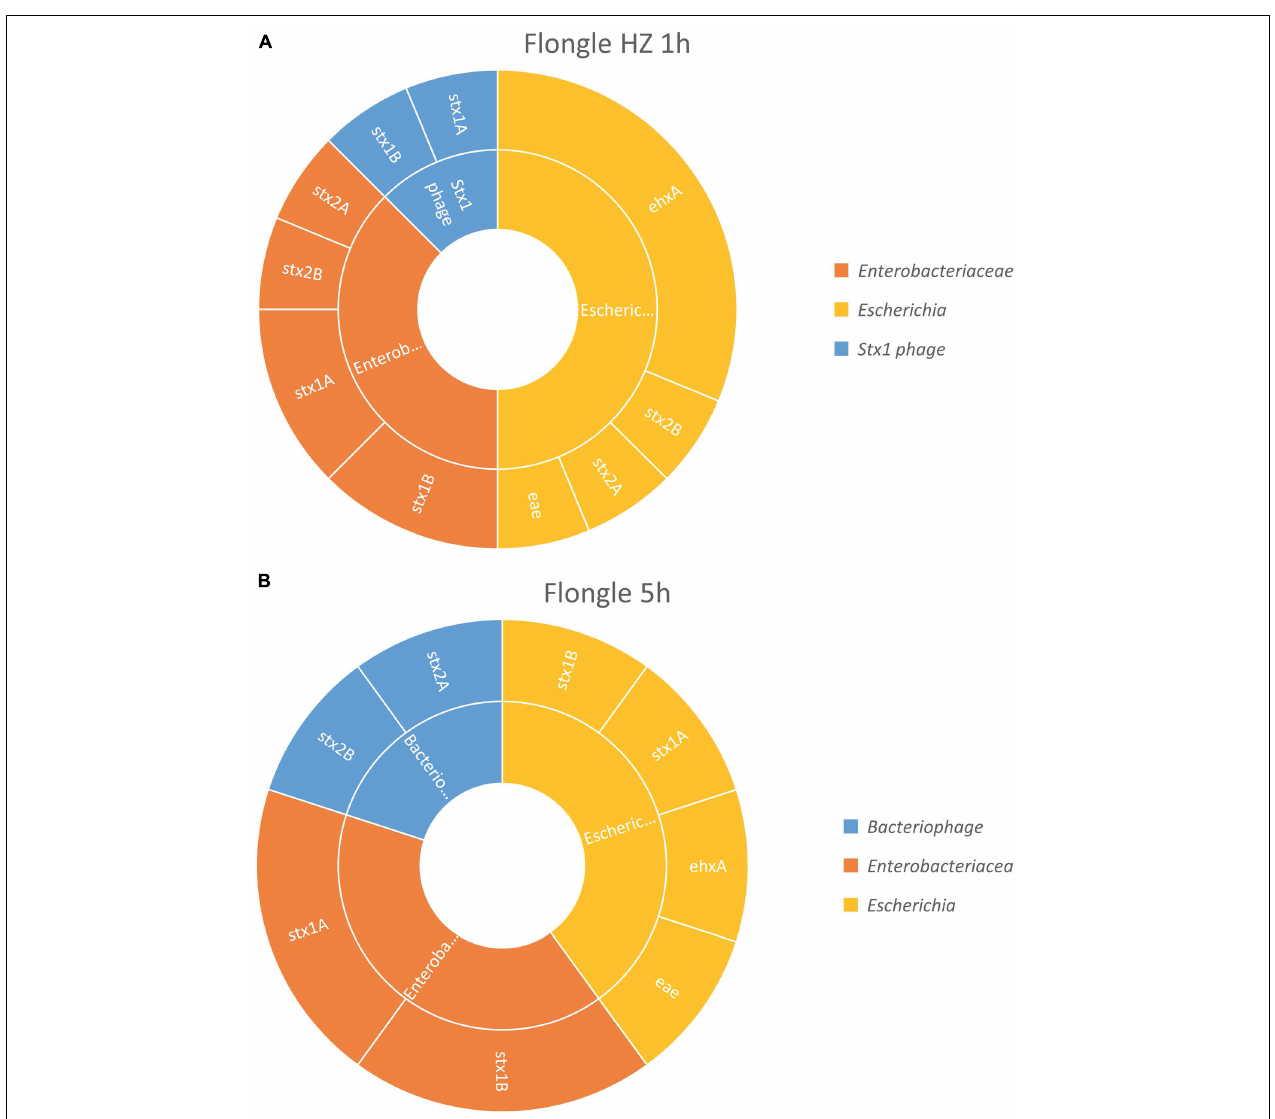
FIGURE 4 | In silico DNA walking results, presenting the genera in the inner circle (following the color scheme specified in the legend) and the genes detected for each taxon in the outer circle of the STEC-spiked beef sample after DNA extraction with or without host removal. (A) Flongle sequencing after 1 h of sequencing, DNA extract with host removal. (B) Flongle sequencing after 5 h of sequencing, DNA extract without host